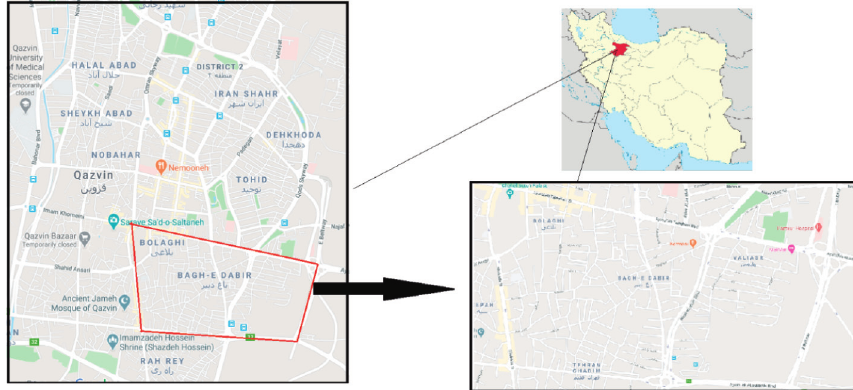
Figure 2: Case study area. Table 2: The features of the case study problems.